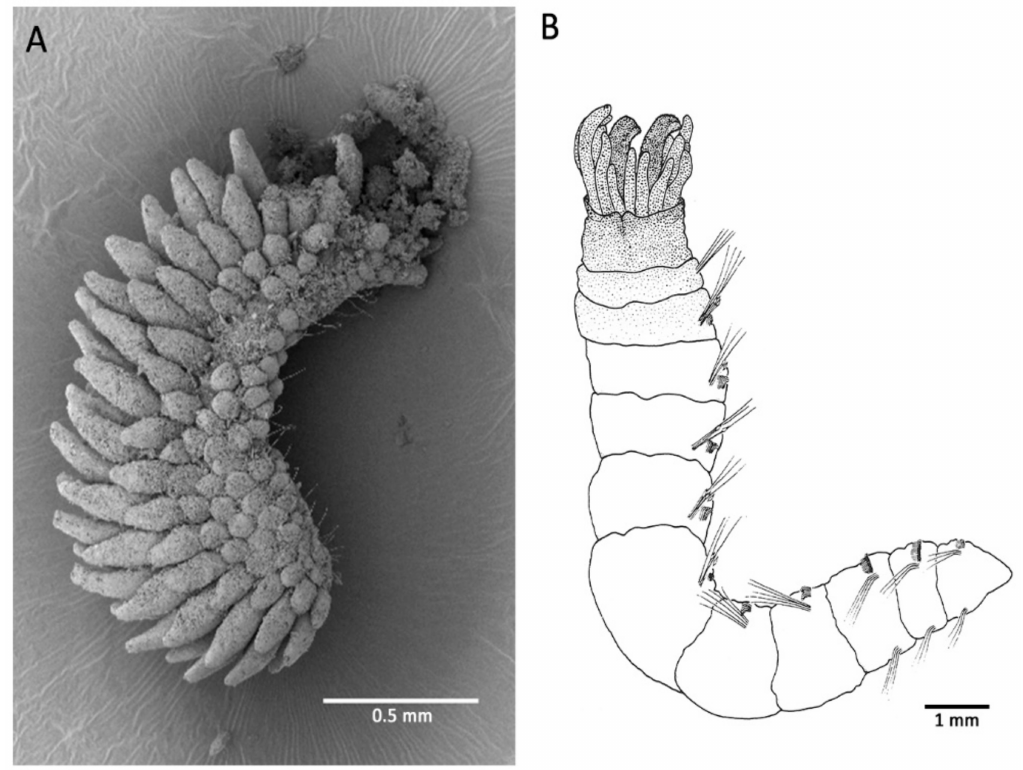
Figure 2. ( A ) The genus Baikalodrilus (Tubificinae, Naididae) is one of the most characteristic faunistic elements of the oligochaete community in Lake Baikal and constitutes a species flock in the lake with no less than 24 morphospecies known to date. Baikalodrilus digitatus is a species with epidermal projections of the body wall, giving the worm a resemblance to some nudibranchs. Photograph: P. Martin. ( B ), Manayunkia athalassia (Fabriciidae) from an ephemeral land-locked lake adjacent to Coorong, South Australia. After Hutchings et al. (1981: Figure 1a